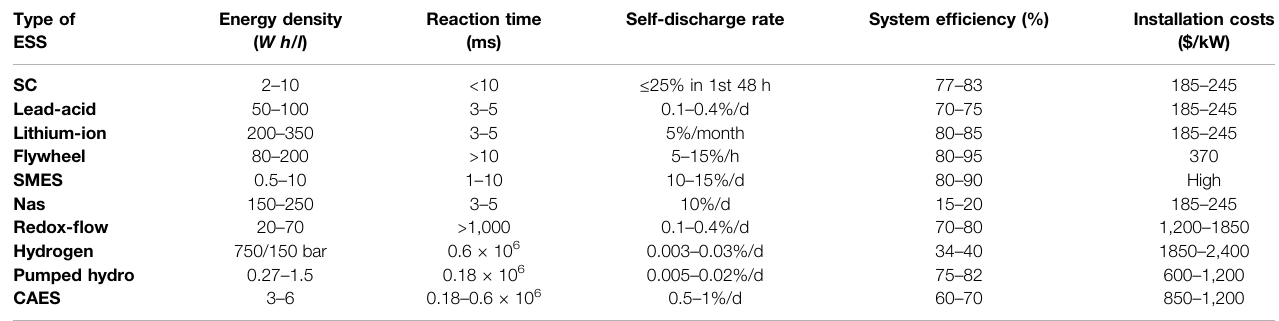
TABLE 1 | Characteristics of different types of